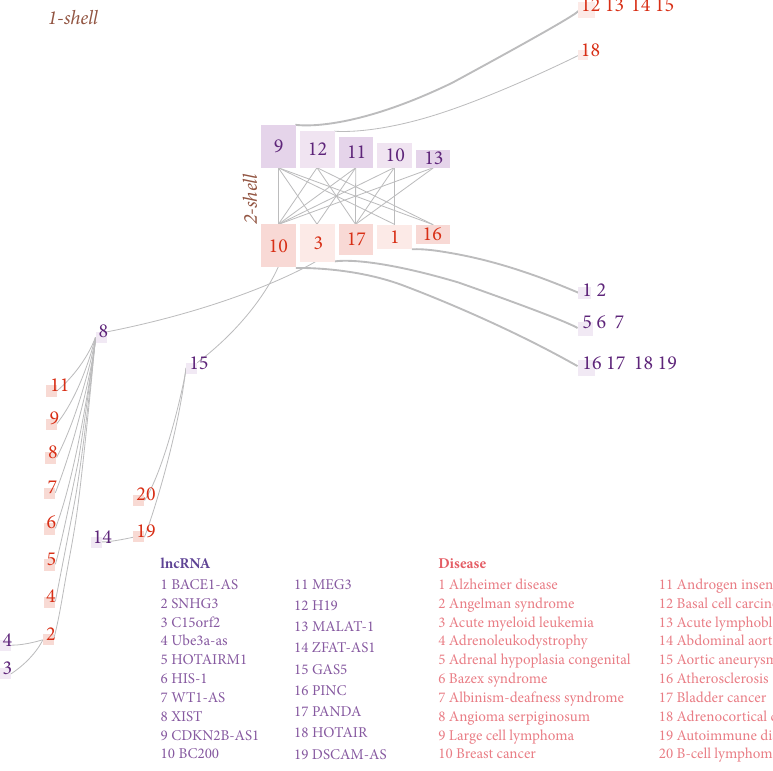
Figure 5: lncRNA-disease association network